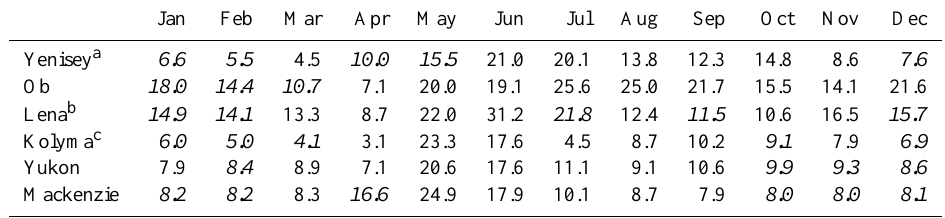
Table A4. Monthly-binned riverine concentrations of DON (mmol Nm − 3 ) . Linearly interpolated values are shown in italic. Jan